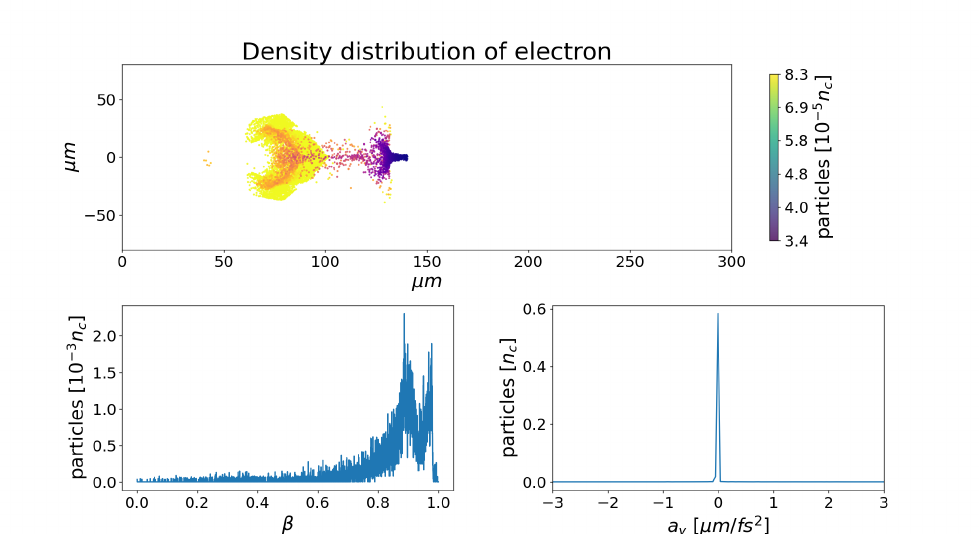
Figure 23. Electrons accelerated by the laser wakefield acceleration (LWFA) mechanism. The top figure is the electron density distribution shown by different colors The bottom left figure is the velocity distribution in β = v / c , where v is the velocity of the electron and c is the speed of light. bottom right of the figure shows the acceleration of the electron on the y -axis.